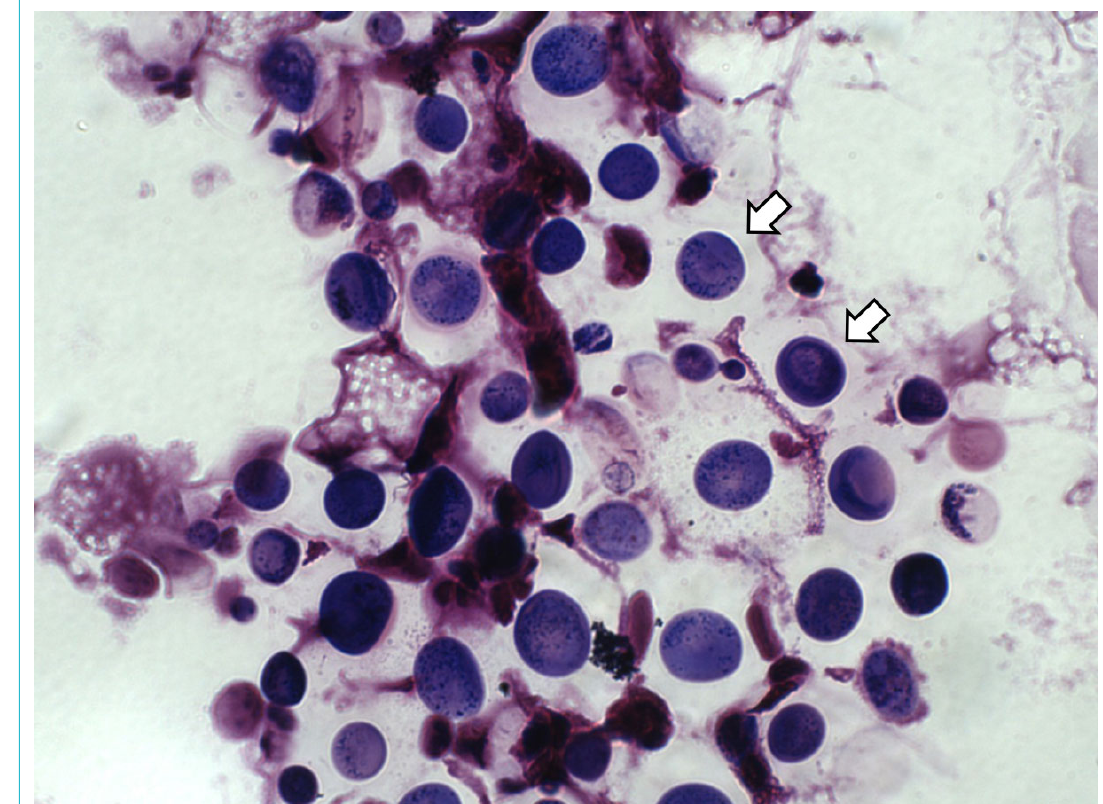
Figure 2: Direct gram stain of broncho-alveolar lavage fluid (magnification 63×) showing large cellular round forms (white